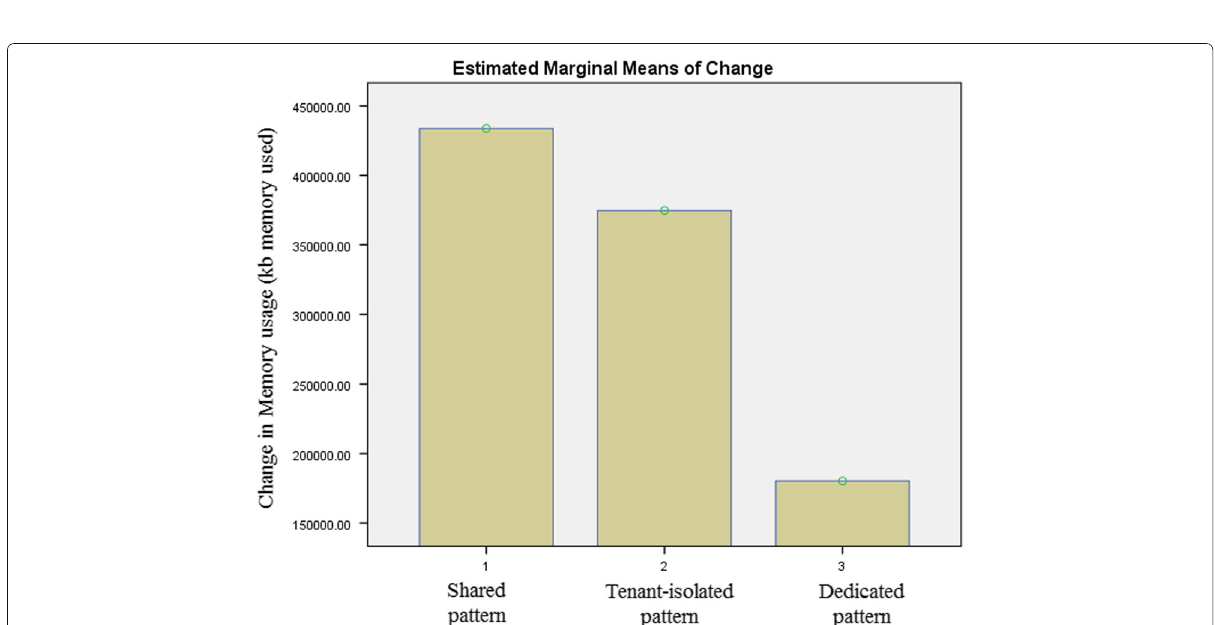
Fig. 12 Changes in Memory